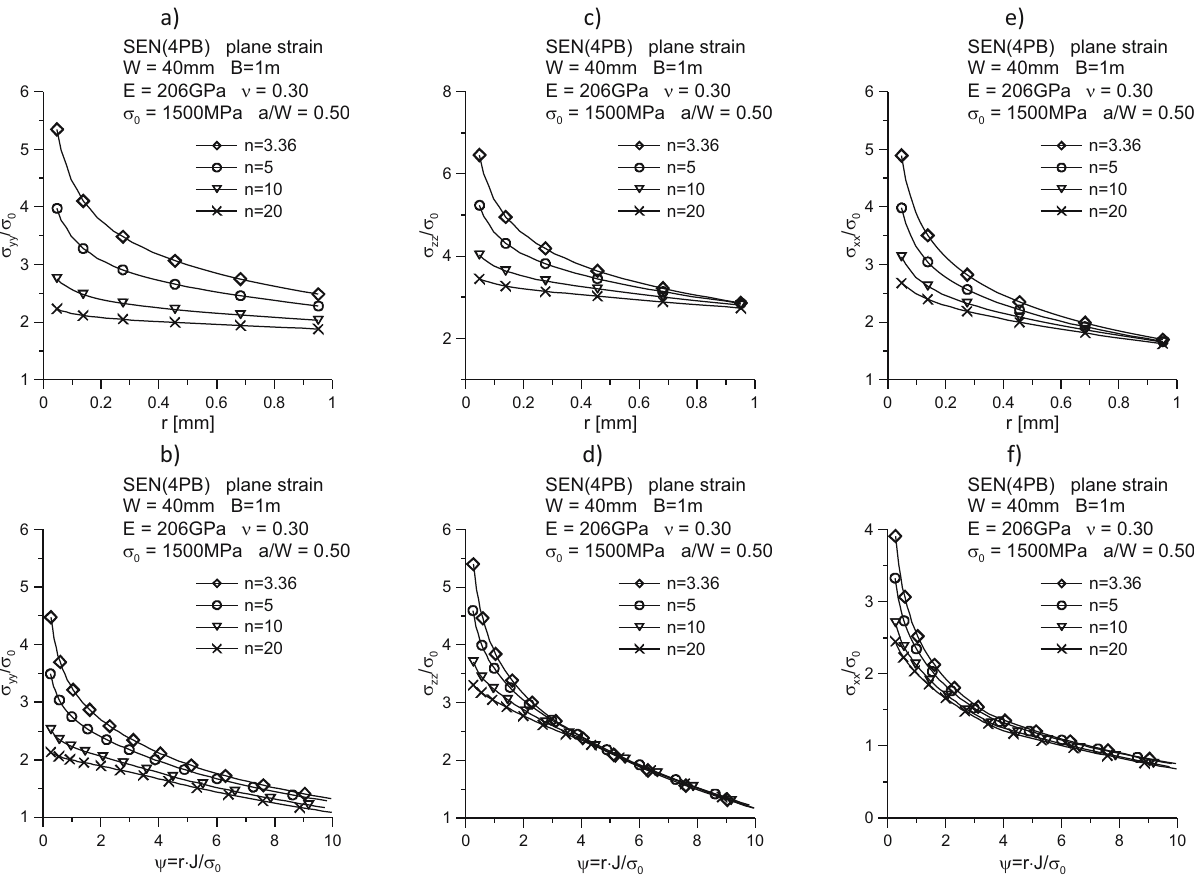
Figure 21: In fl uence of the strain hardening exponent n on the distribution of the main stress tensor components: components in the plane of crack propagation σ yy / σ 0 ( a and b ) and σ zz / σ 0 ( c and d ) and the component in the thickness direction ( along the crack front ) σ xx / σ 0 ( e and f ) , near the crack tip ( graphs ( a, c, and e ) were prepared for the physical distance from the crack tip; graphs ( b, d, and f ) were prepared for the normalized distance from the crack tip ψ = r · J / σ 0 ; the charts are presented for the moment when the external load reaches the limit load value – P / P 0 = 1.00; with the following values ofthe J integral for subsequent specimens: n = 3.36, J = 547.4kN/m; n = 5, J = 573.8kN/m; n = 10, J = 651.1 kN/m; n = 20, J = 674.1 kN/m )